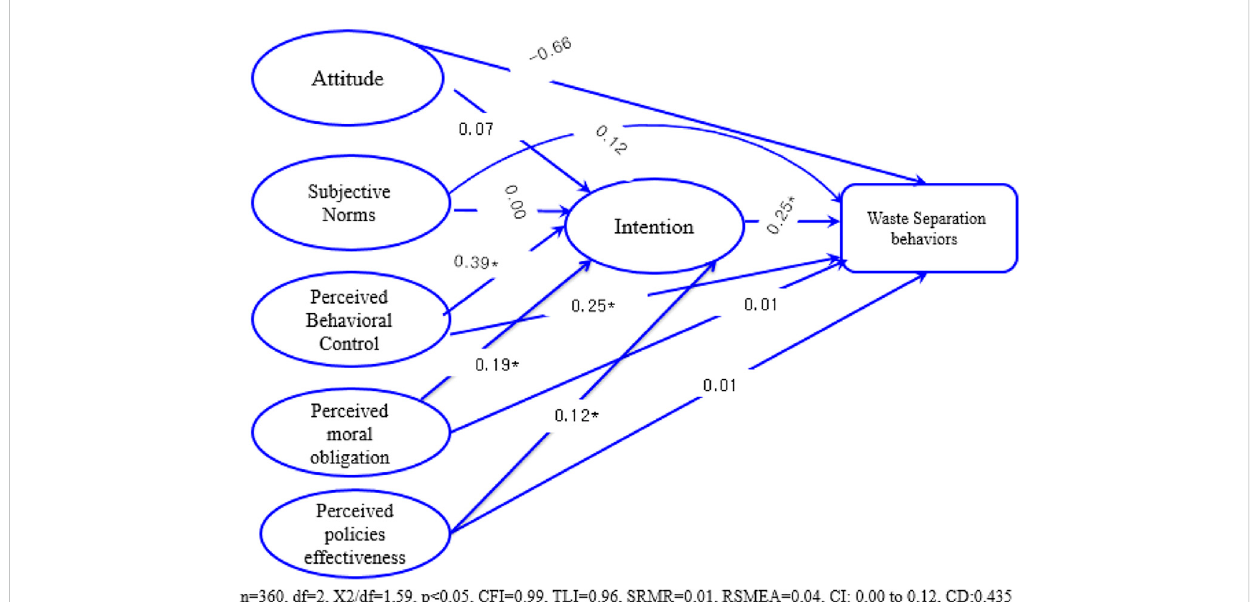
FIGURE 1 Cognitive predictors of waste separation